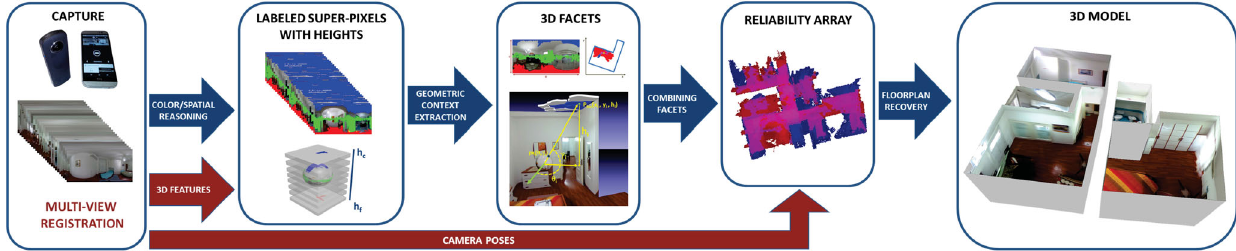
Overview: for each spherical image, we perform image classification using super-pixels , labeling only those super-pixels that can be unambiguously assigned to floor, walls, and ceilings (see Section 5.1). In parallel we recover camera and feature alignment by multi-view image registration. We use these features to assign the most likely height value to each super-pixel. Once the heights are known we use a custom 3D mapping function to recover 3D world space points from image-space super-pixels (see Section 5.2), to generate a 3D world space facet distribution and a 2D accumulation array. We then use these to recover the scene floor-plan and 3D room shapes (see Section